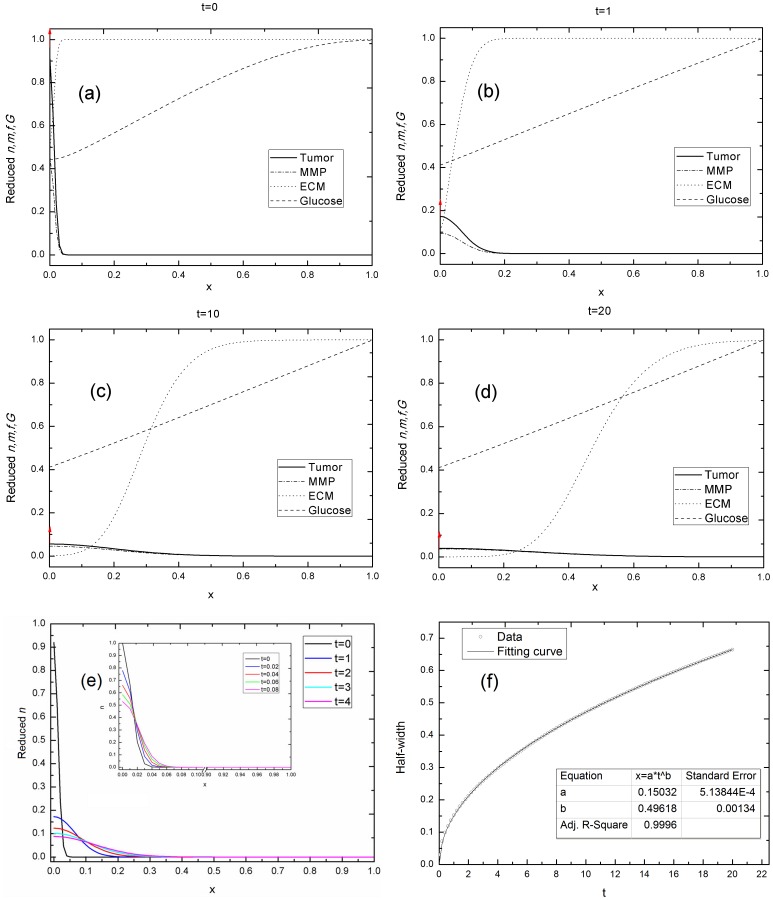
Tumor invasion is unaffected by the microenvironment.(a–d) The time evolution of the n, MMP, ECM, and glucose in a one-dimensional spatial length x at time (a) t = 0, (b) t = 1, (c) t = 10, and (d) t = 20. (e) The cell density n(x,t) when t ranges from 0 to 20. The inset shows t ranging from 0 to 0.08. (f) The curve fitting the half-width of cell density versus evolution time data, xh-t, b = 0.49618±0.00134. Simulation parameters: γf = γG = λ = β = λa = 0. The rests of the parameters were fixed. The ECM is degraded by the MMP; the simulated exponent b in this situation is almost 0.5, the typical Fickian diffusion.